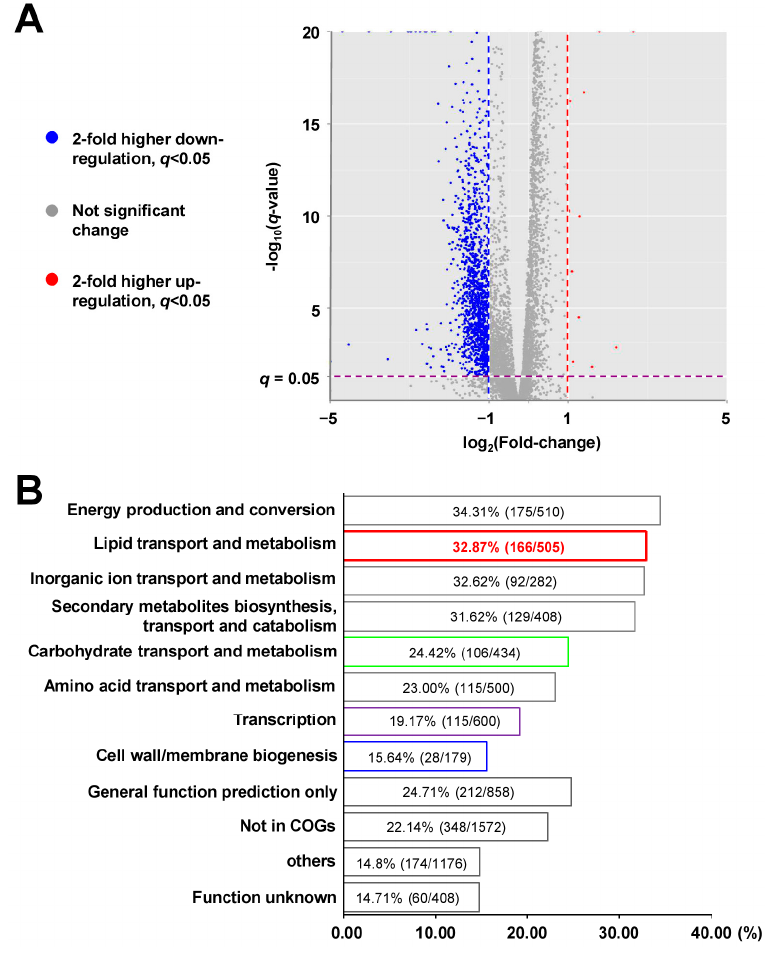
Figure 3. Transcriptomic assays for the effect of xylR on the gene expression of M. smegmatis . ( A ) The volcanic diagram shows gene expression differences between Msm/pMV261 and Msm/pMV261- xylR strains through transcriptomic analysis. The blue spots show that genes are significantly down-regulated. The red and gray spots show significantly up-regulated genes and not significantly changed genes, respectively. ( B ) Functional categories of 1494 significantly down-regulated target genes of XylR in M. smegmatis . Classification of the target genes was analyzed in terms of COG categories.